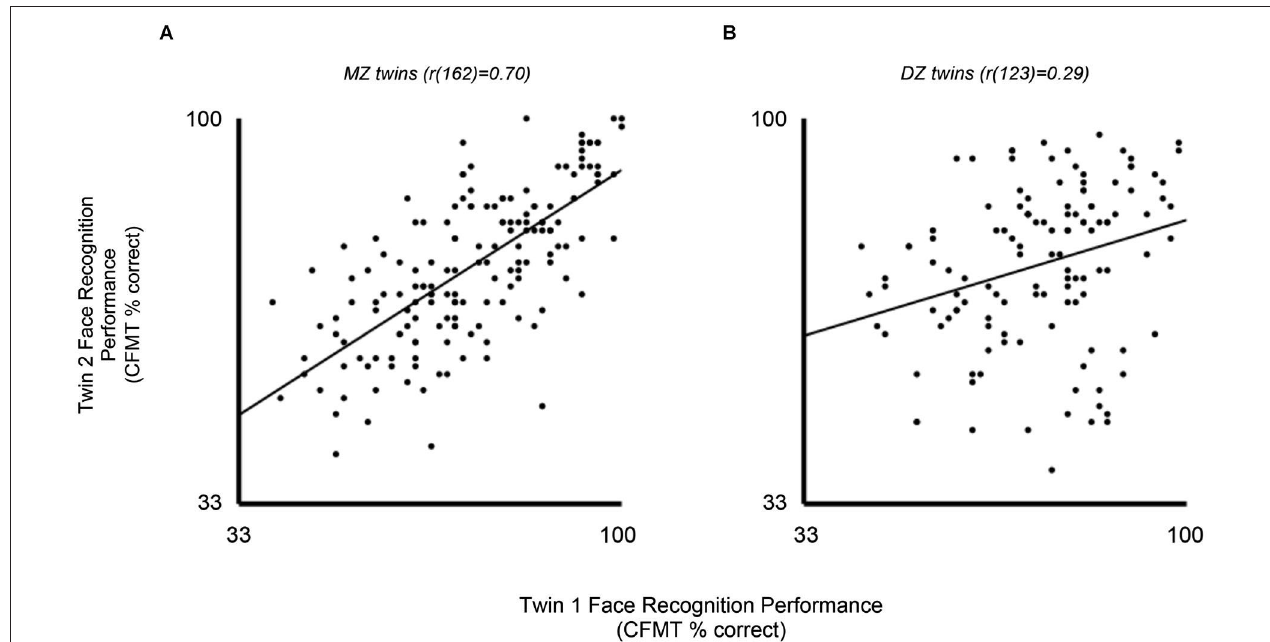
and DZ correlation is rDZ(123) = 0.29. The high rMZ indicates high family resemblance for CFMT performance, whereas the rDZ of less than half the rMZ indicates that most or all of this family resemblance can be attributed to family genes rather than family